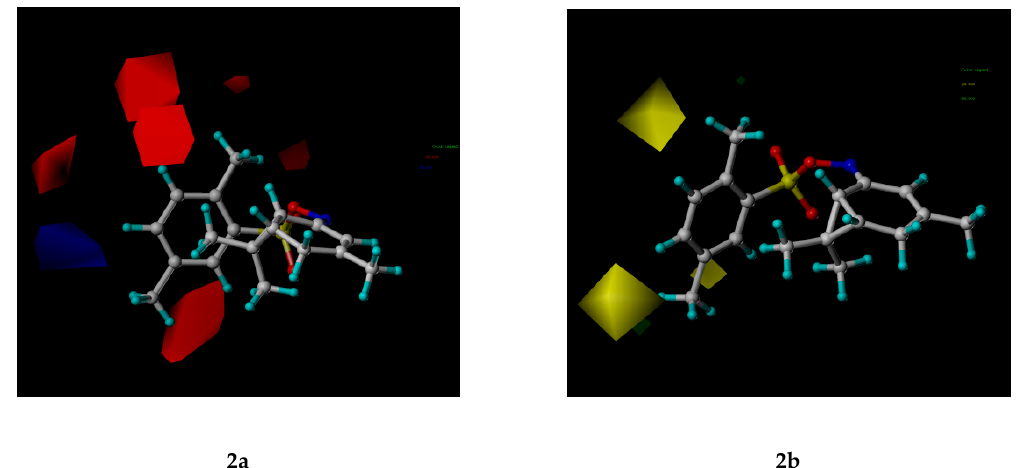
Figure 1. Predicted vs experimental ED values of CoMFA.